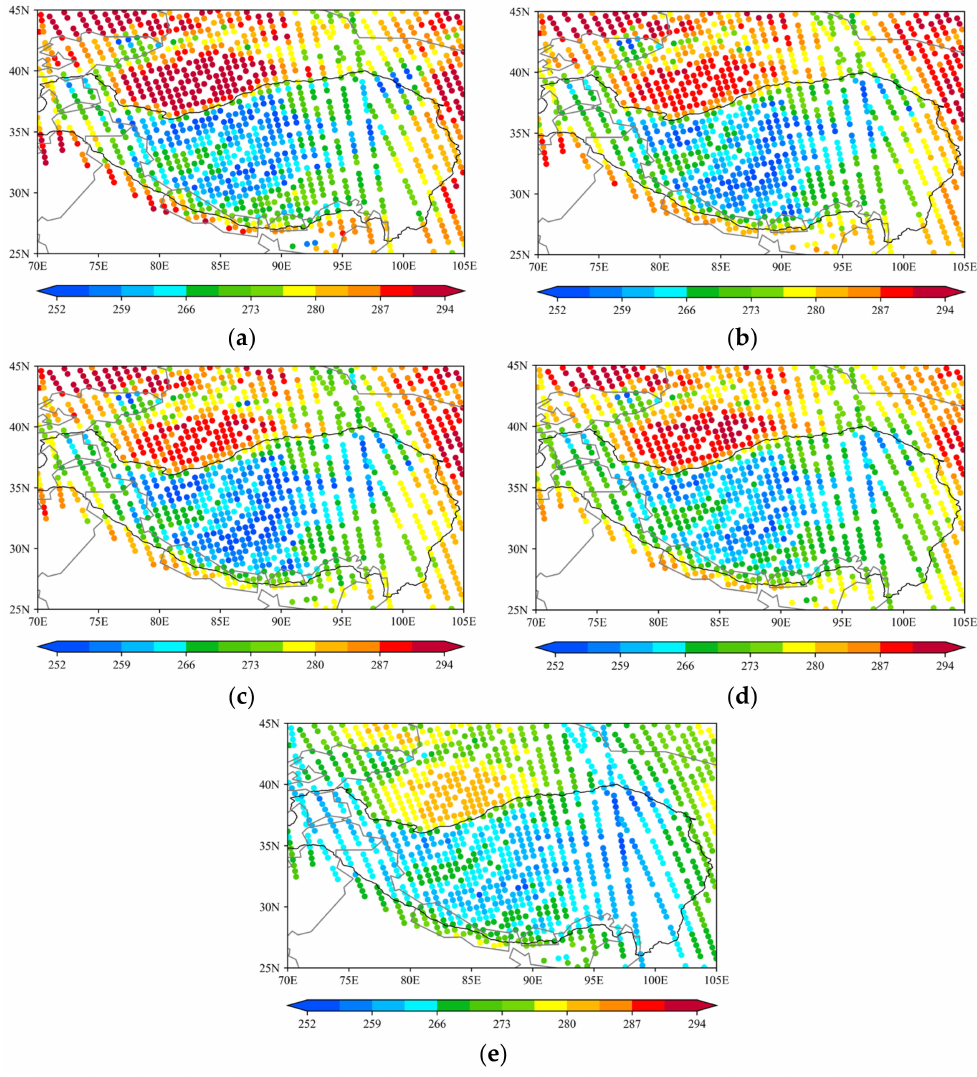
Figure 3. Spatial distribution of the observed BT of AMSU-A ( a ) channel 15 and ( b – e ) channels 1–4 (unit: K) over the Tibetan Plateau region at 1200 UTC 12 August